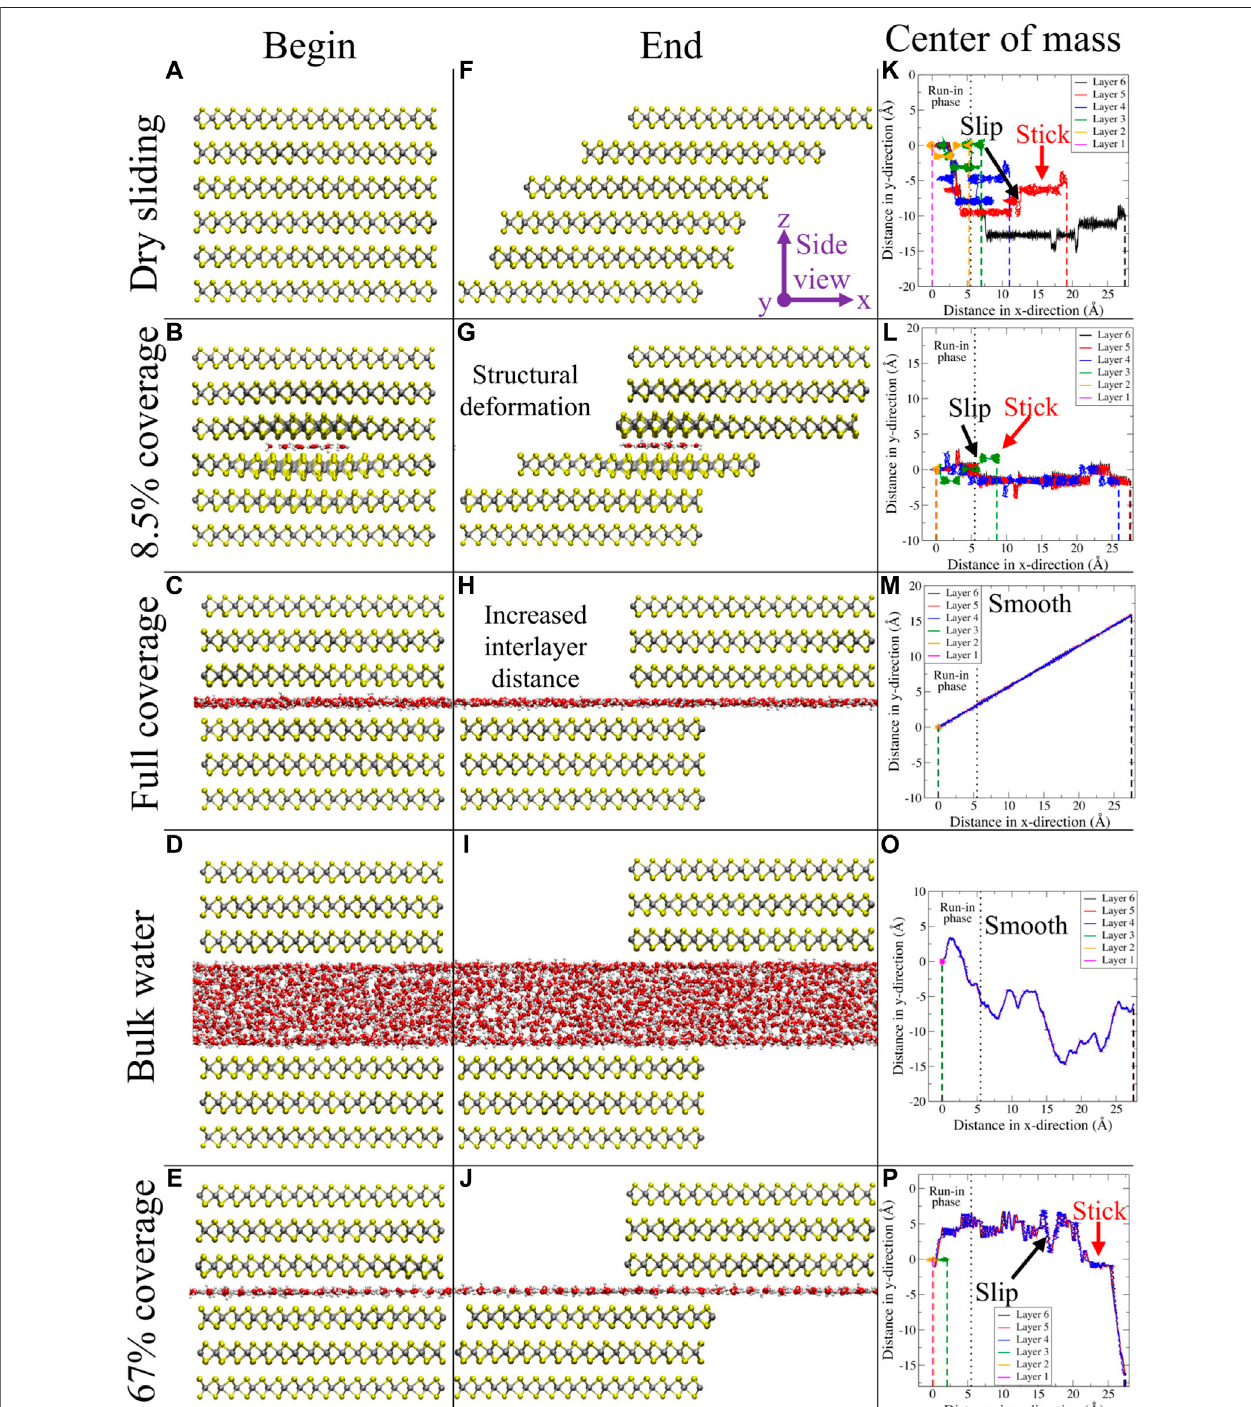
FIGURE 3 | In the fi rst two columns, snapshots for different con fi gurations taken at the beginning (A – E) and the end (F – J) of the simulations are presented from a side view perspective. Respective con fi gurations are dry sliding, 8.5% coverage, full coverage, bulk water, and 67% coverage. In the third column (K – O) , the center of mass for every layer is depicted in the xy -plane. The vertical black dotted linein this column represents the end ofthe run-in phase (which isdiscarded in the quantitative analysis), while the vertical dashed lines in this column represent the fi nal x -position for every layer. Figure was obtained with VMD (Humphrey et al., 1996).